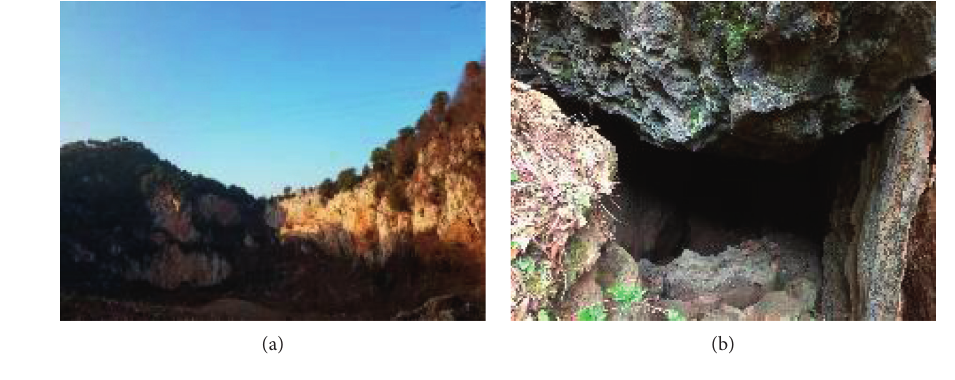
Figure 4: Karst pit and doline.